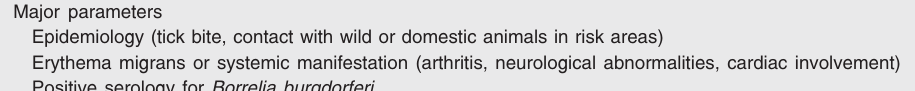
Table 2. Diagnostic criteria of Lyme disease-like syndrome adopted by the Discipline of Rheumatology, Hospital das Clínicas, Faculdade de Medicina, Universidade de São Paulo. Major